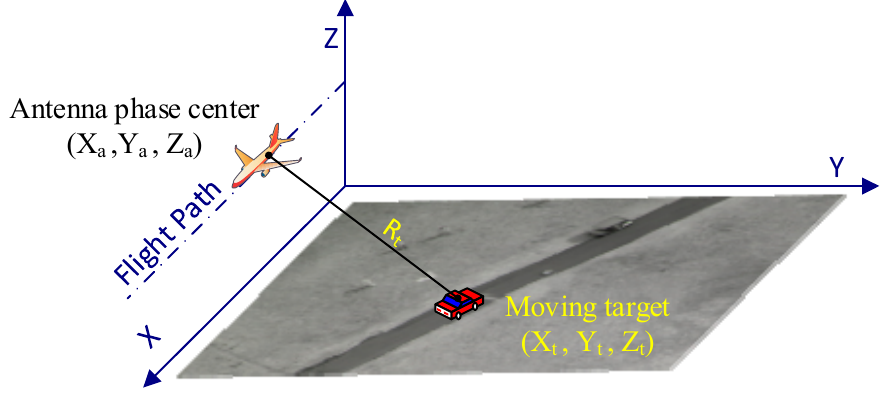
Figure 1. The SAR system geometry.